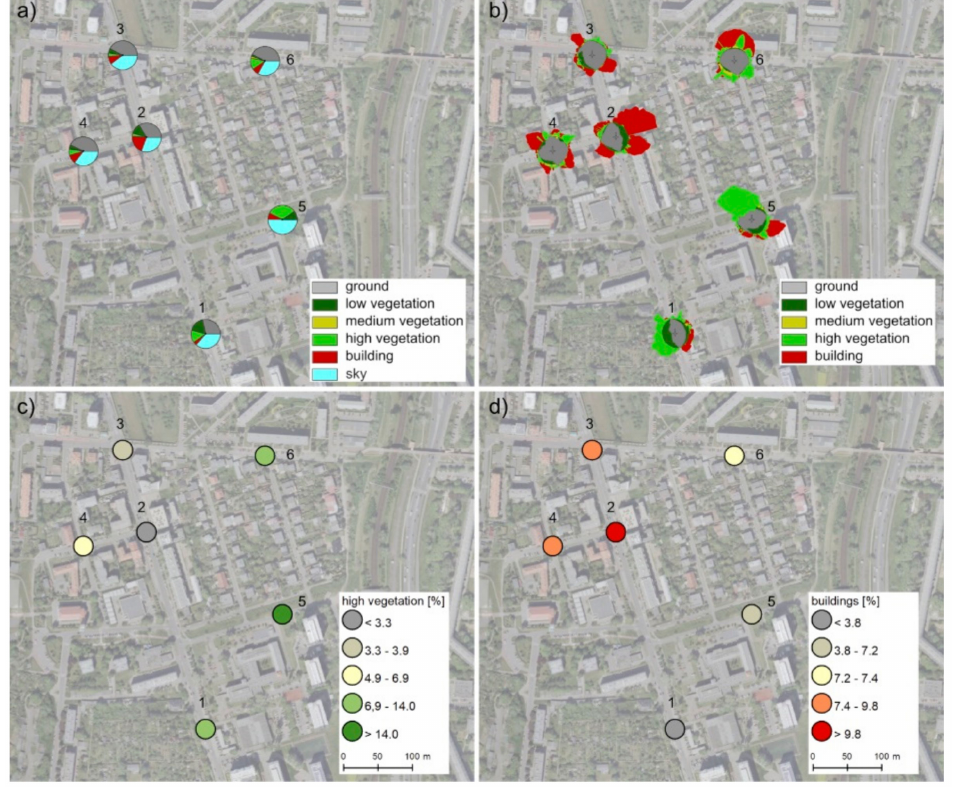
Figure 6. Results of quantitative landscape assessment—pie charts ( a ), little planet ( b ), high vegetation fraction ( c ), buildings fractions ( d